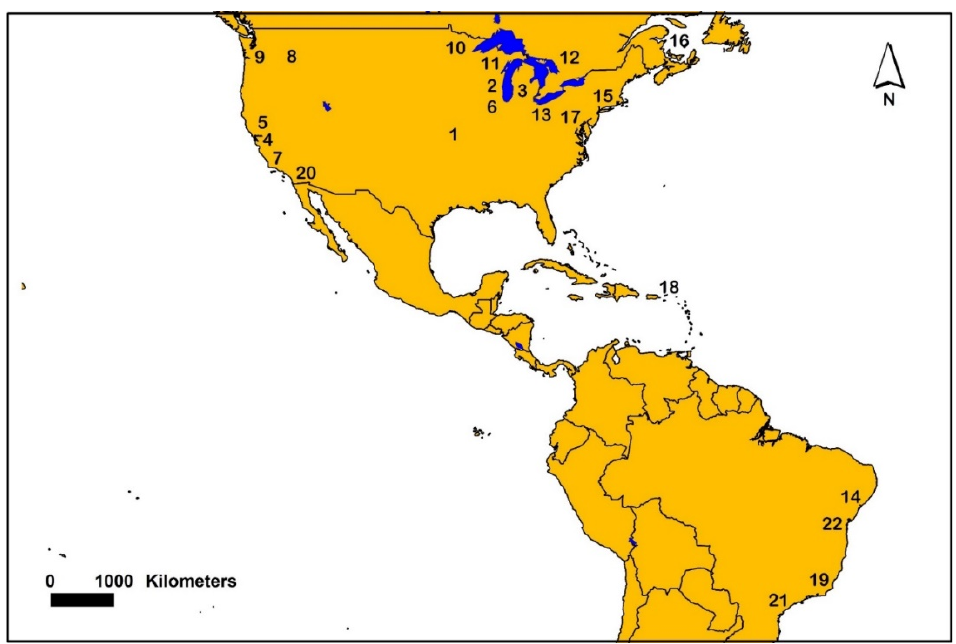
Figure 1. Map showing generalized locations where sediment AVS was sampled from various studies in North and South America. Number symbols on the map are associated with individual or multiple studies and references. The following numbers and associated references are: 1 [14], 2 [15], 3 [16,24], 4 [17,18], 5 [18,21], 6 [19], 7 [20], 8 [24,25,32], 9 [34], 10 [11,15,35,38], 11 [24], 12 [36], 13 [37], 14 [43], 15 [3,44,49], 16 [52], 17 [52,60], 18 [53], 19 [58], 20 [59], 21[63] and 22 [67].